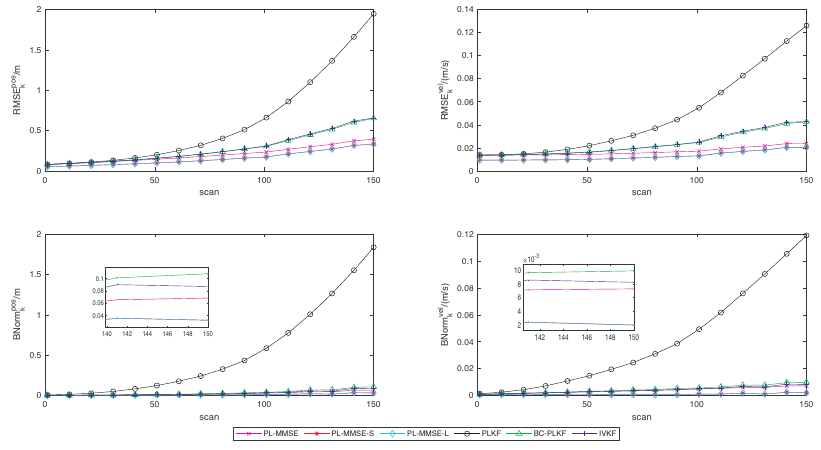
Figure 13. RMSEs, BNorms and time kT for σ θ = 7 ◦ at V = 0.2 m/s for the PL-MMSE, PLKF, BC- PLKF and IVKF algorithms, as well as, the proposed PL-MMSE algorithm with nonlinear constraints in the paper.